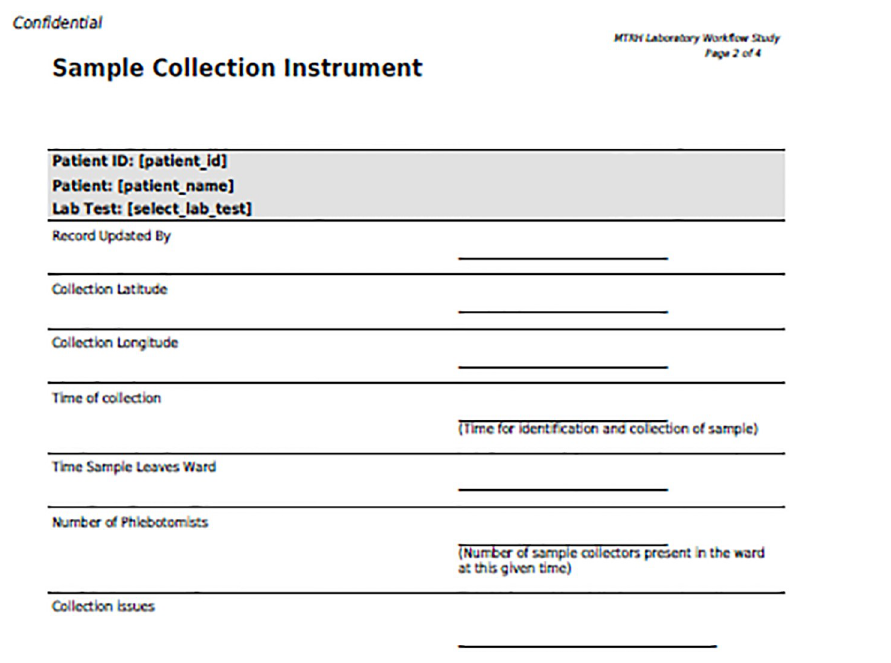
Fig 8. Sample collection instrument. Instrument used to record data during sample collection.